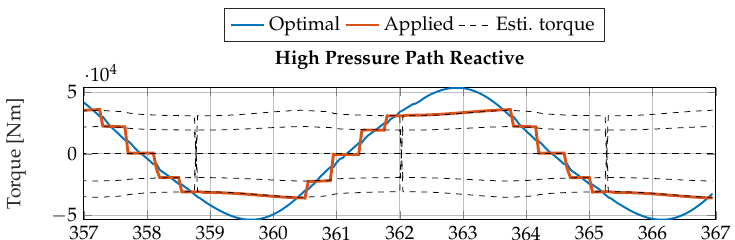
Figure 10. Actual PTO torque and ideal PTO torque for the high-pressure path-aided reactive strategy measured with a system pressure of ~115 bar. Wave input: Regular with a height of 0.35 m. and a period of 6.5